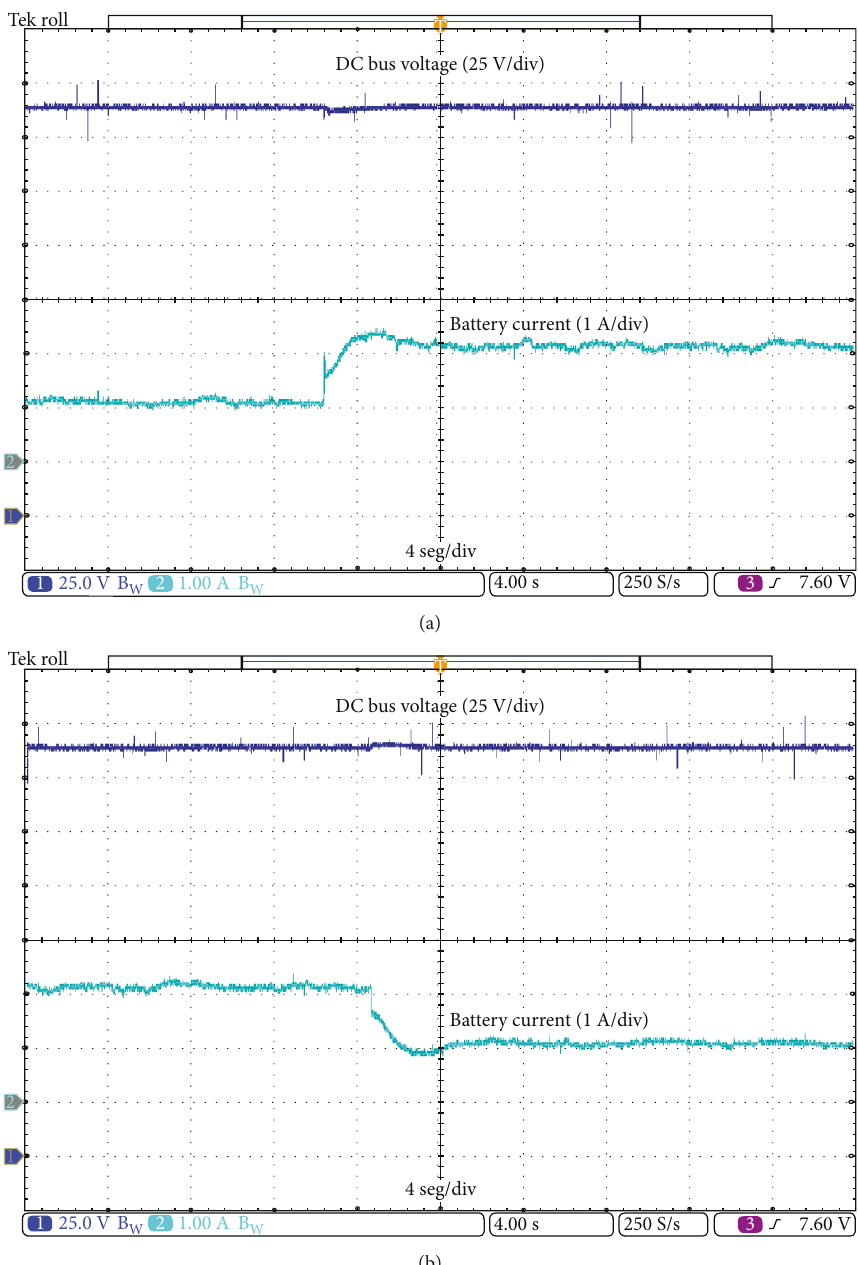
Figure 11: (a) Connection of 125W LED lamps and (b) disconnection of 125W LED